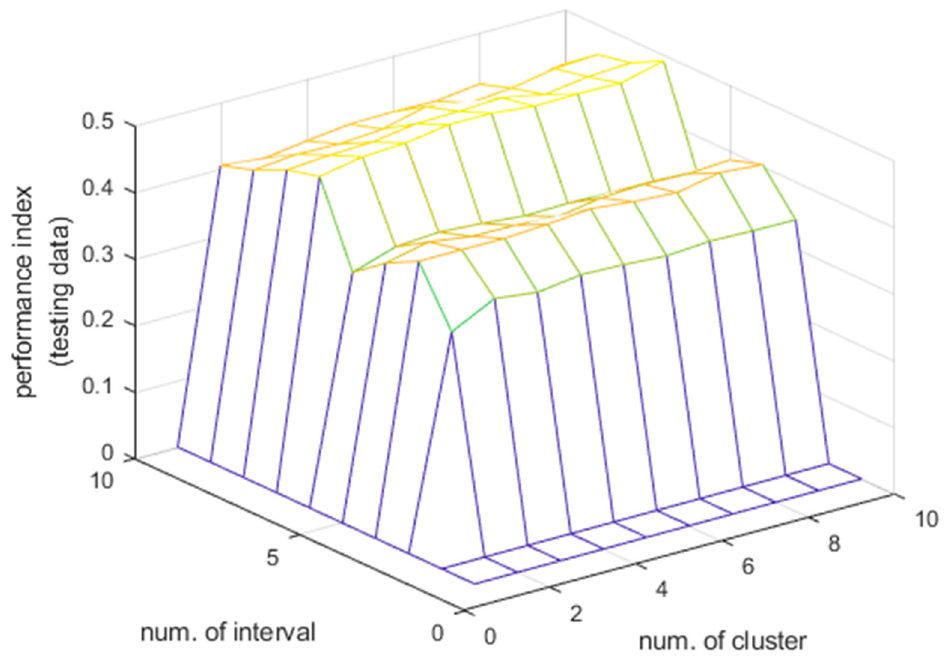
Figure 13. Results of PI method for interval-based IGM (Case 2).